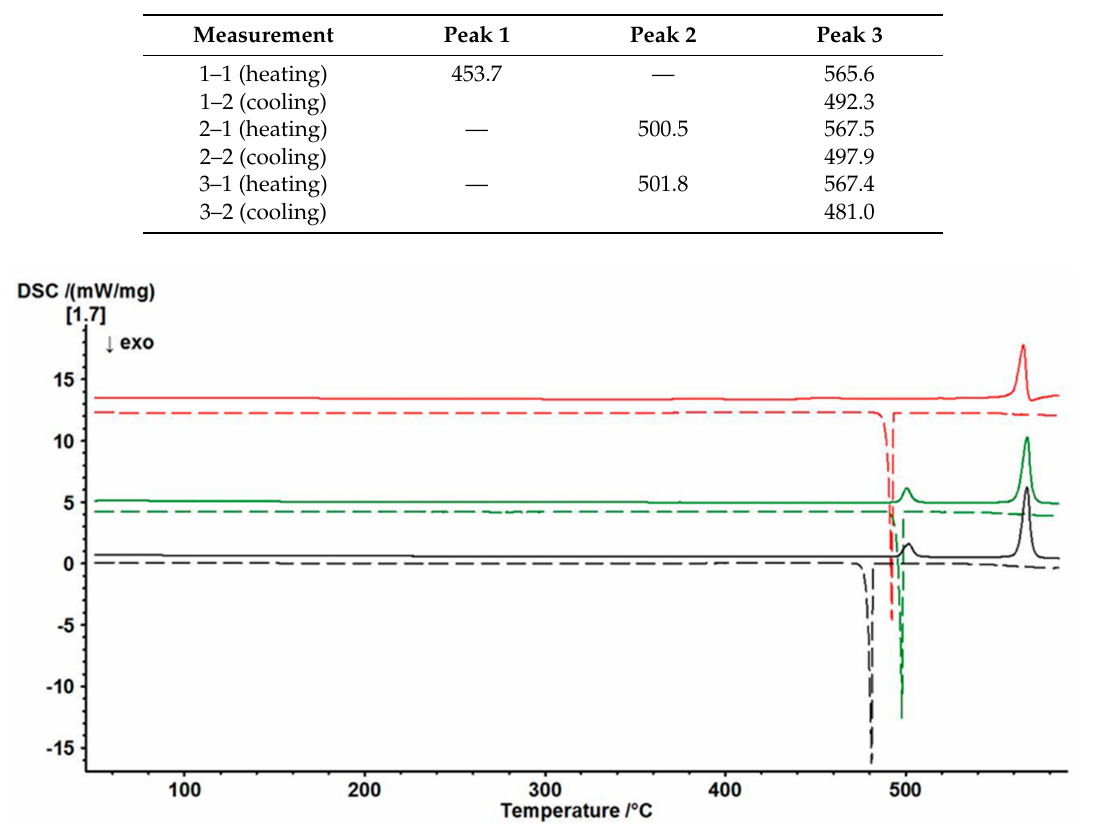
Table 4. Peak maxima ( ◦ C) during three subsequent heating/cooling cycles of γ -PbTeO 3 as starting material.